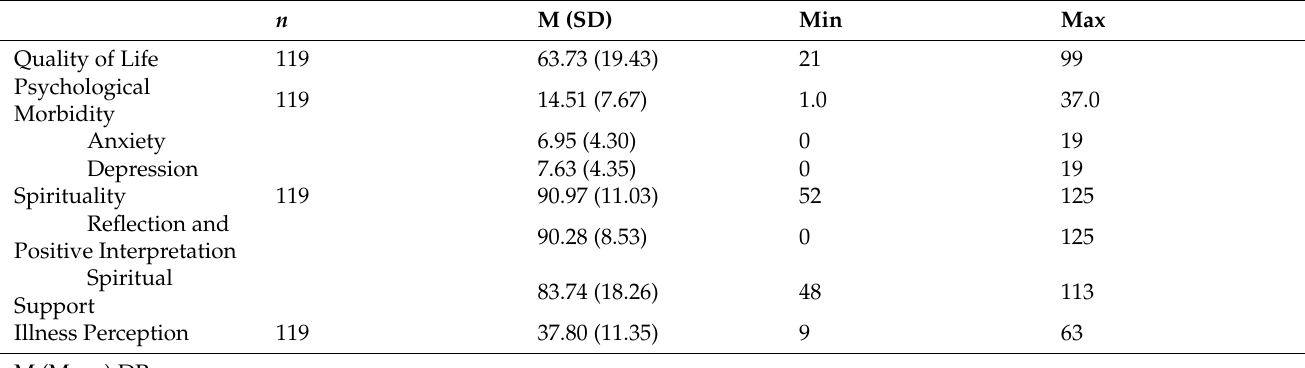
Table 2. Psychological characteristics of the sample group.